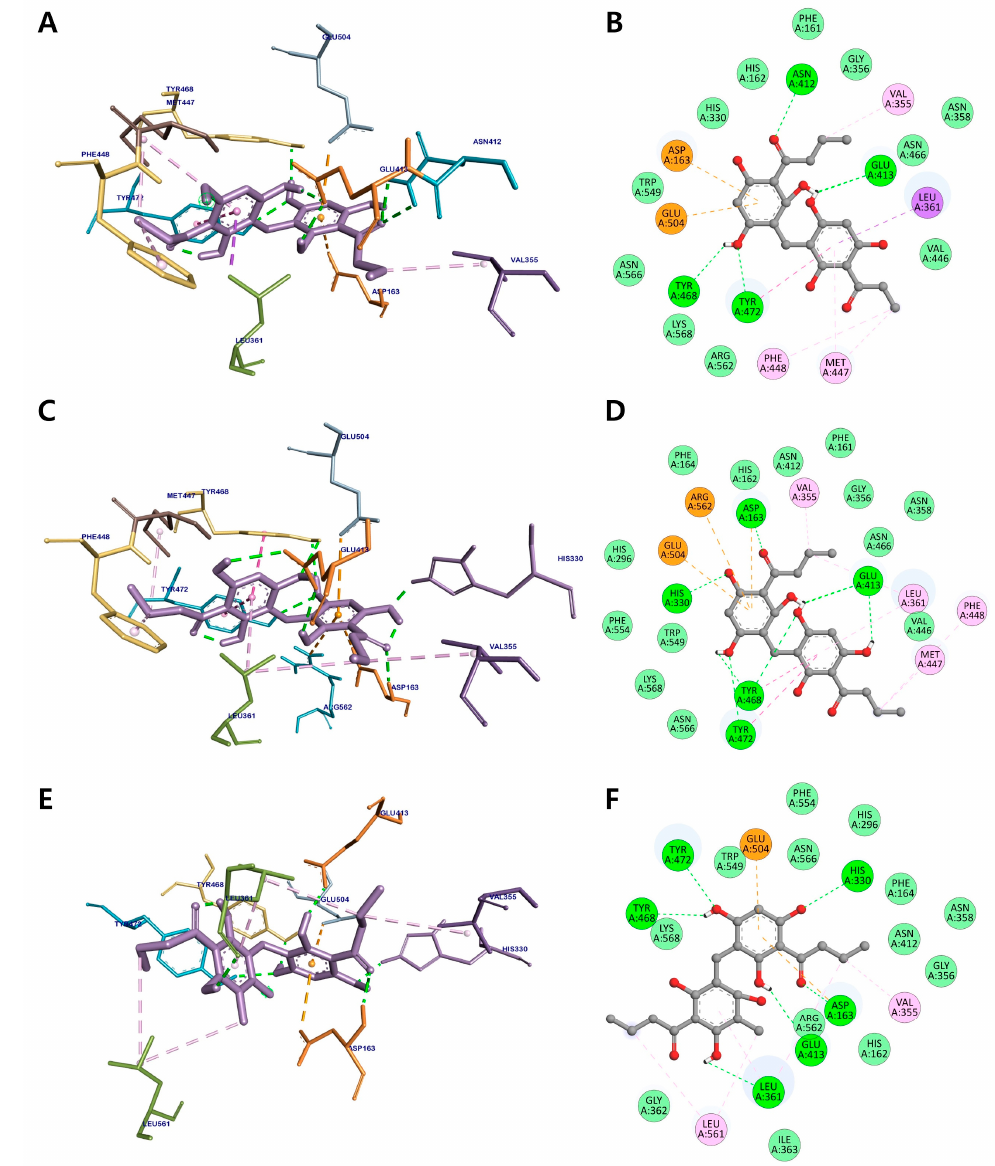
Figure 6. Three-dimensional molecular docking ( A , C , E ) and 2D interaction diagrams ( B , D , F ) of β -glucuronidase inhibition by dimeric phloroglucinols 13 – 15 , respectively. Green: hydrogen bonding interactions, light green: van der Waals interactions, pink: hydrophobic interactions, and orange: electrostatic interactions with the corresponding amino acid residues of β -glucuronidase.